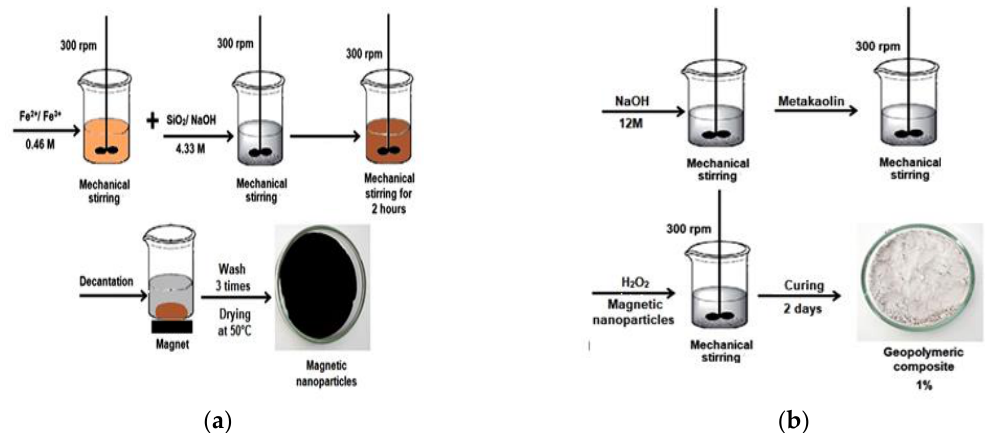
Materials 2021 , 14 , x FOR PEER REVIEW Figure 2. Modification process of magnetic nanoparticles with SiO2 ( a ) and production of geopolymer composites ( b ).